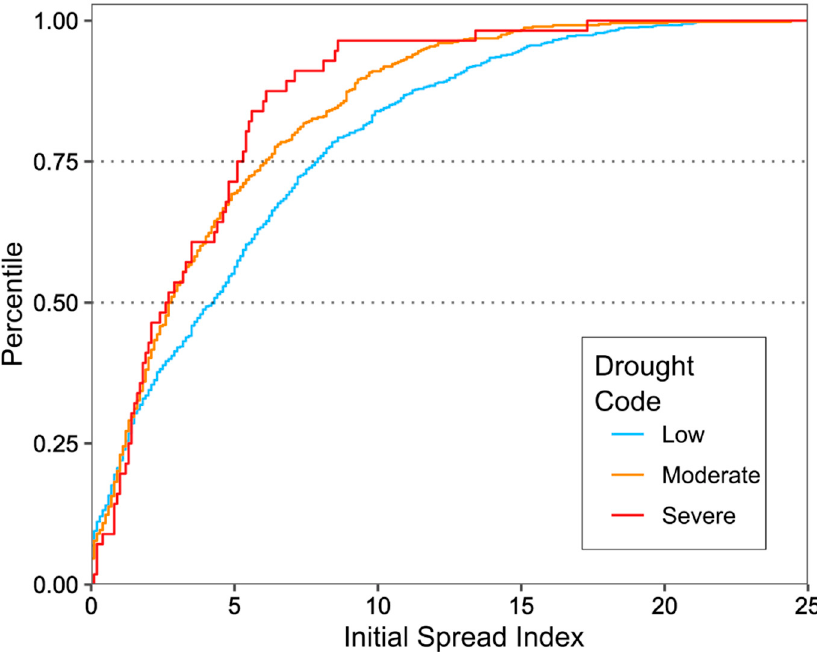
Figure A4. Historical cumulative distribution of the daily fire spread potential, Initial Spread Index, at Fort Smith from 1970 to 2015, stratified by Drought Code scenario.